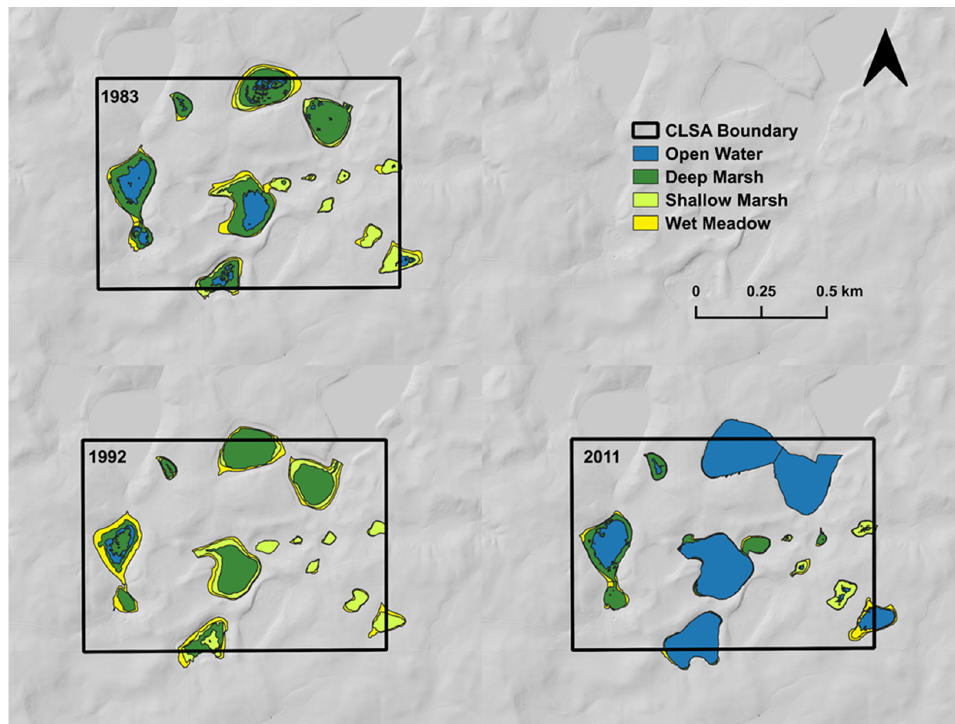
Figure 4. Three maps representing vegetation zone areas for cottonwood lake study are wetlands in